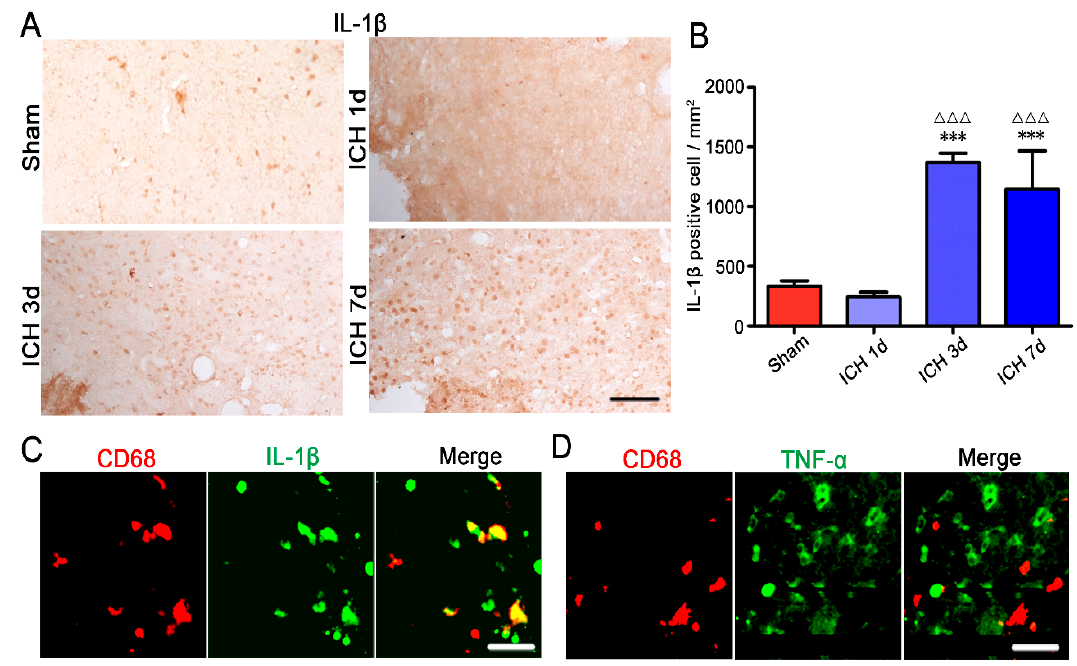
Figure 4. Increased IL-1 β in the hemorrhagic CPu was detected at three and seven days after collagenase VII injection. IL-1 β in the CPu was studied by immunohistochemistry ( A , B , Bar = 100 μ m) on brain slices (20 μ m) at one, three, and seven days after collagenase VII injection (ICH 1 d, 3 d and 7 d, n = 3). Control CPu (Sham) was from 2 μ L 0.9% NaCl injected rats ( n = 3). Data were expressed as means ± SEM. *** p < 0.001, vs. Sham. ΔΔΔ p < 0.001 vs. ICH 1 d. To study the cytokine expressions of activated microglia in the hemorrhagic center, brain slices were double-stained with antibodies specific to pro-inflammatory cytokines interleukin (IL)-1 β ( C , green) ortumor necrosis factor- α (TNF- α ) ( D , green) and CD68 (red in C , D , n = 3). Bar = 50 μ m.